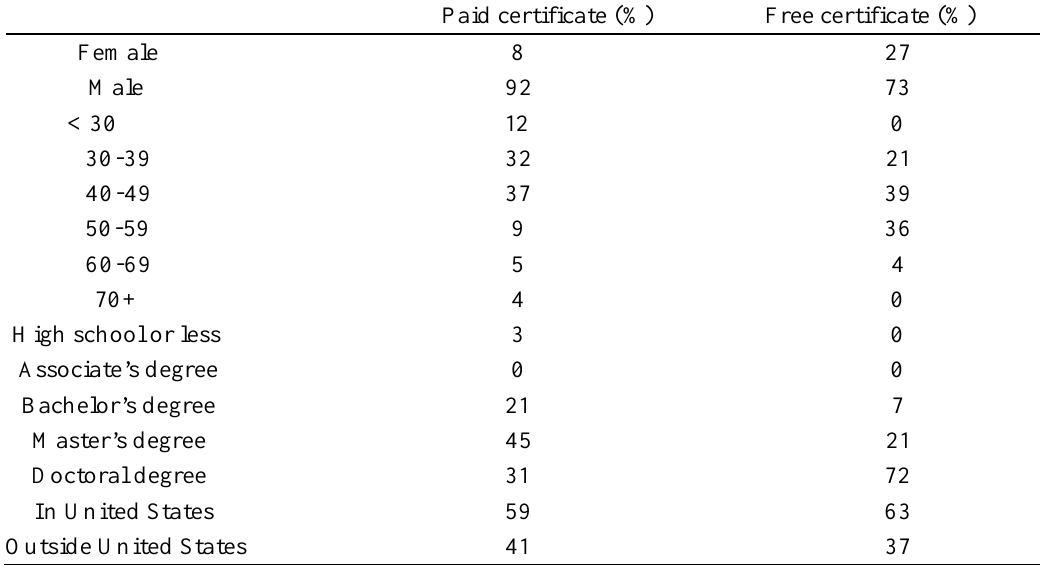
Case Study 2: Demographics of Verified Users in Free- and Paid-Certificate-Track